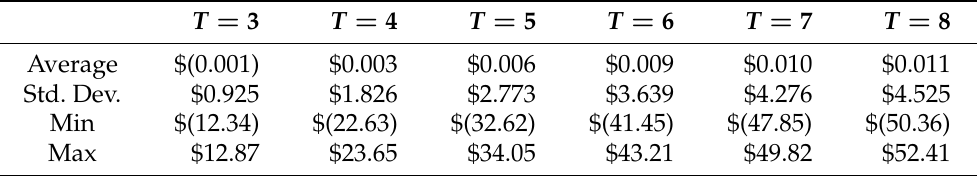
Table 3. Tracking error for futures contracts.